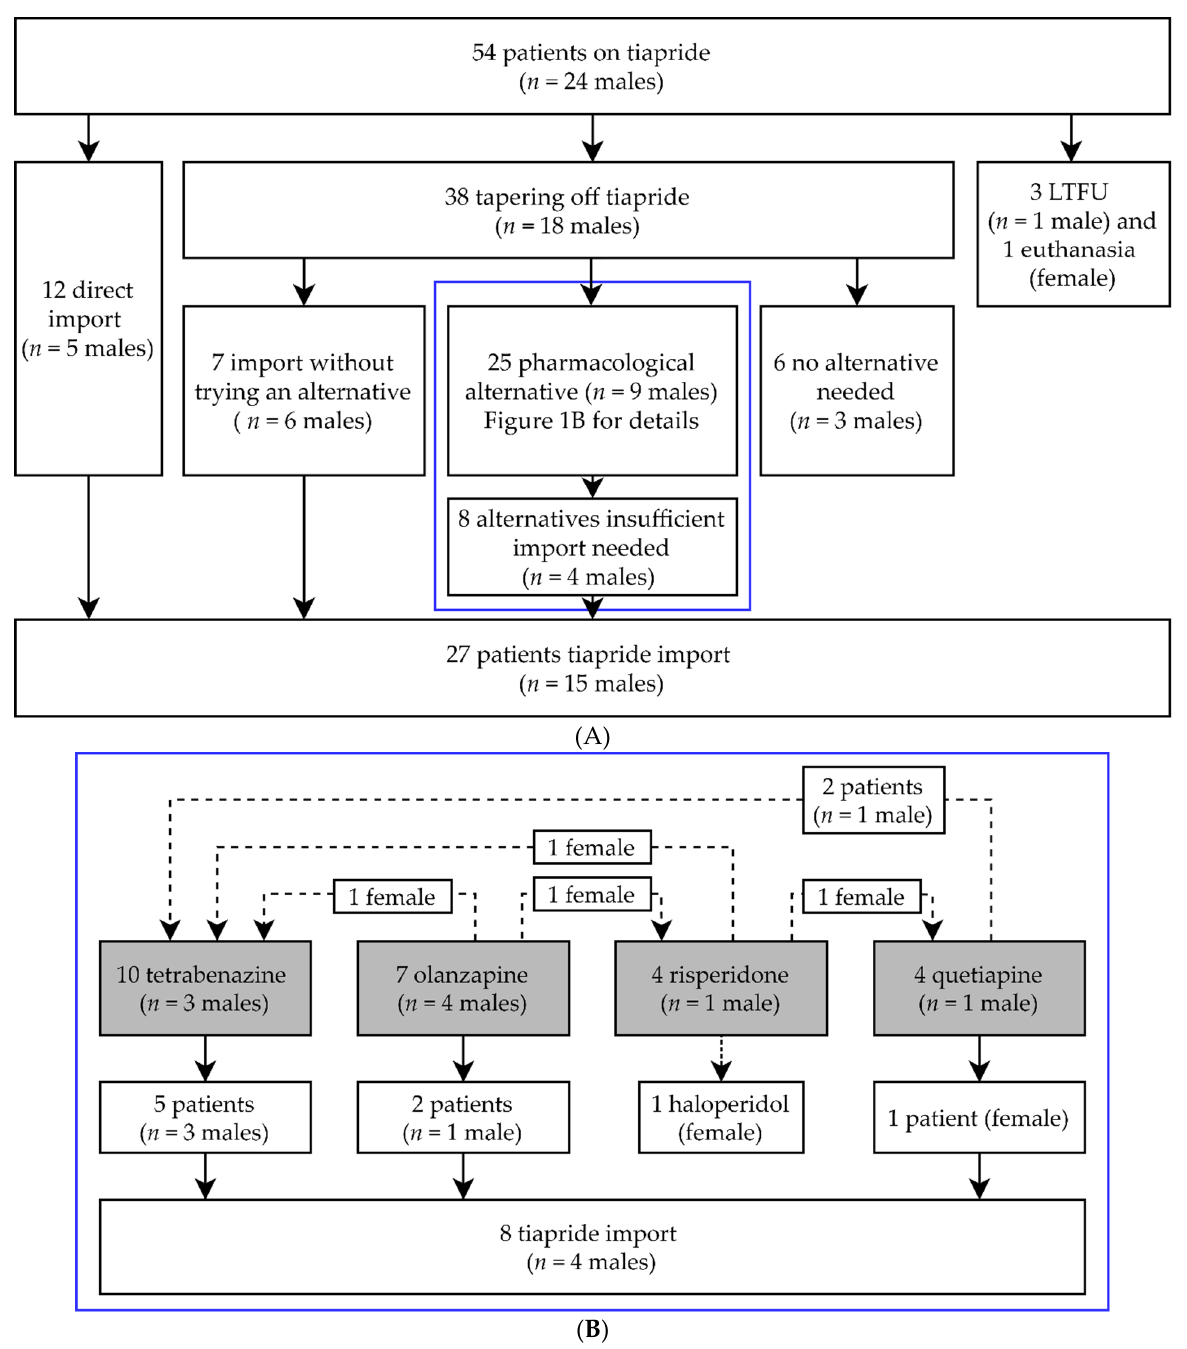
Figure 1. ( A ) General overview of clinical follow-up and tiapride import. In the blue box are those patients that were prescribed a pharmacological alternative. ( B ) describes these pharmacological alternatives in more detail; n = number of; LTFU = Lost to follow-up. ( B ) Enlargement of blue box ( A ). Details of pharmacological alternatives used. Gray boxes are the original pharmacological alternatives prescribed. Dotted lines are patients who switched between pharmacological alternatives; n = number